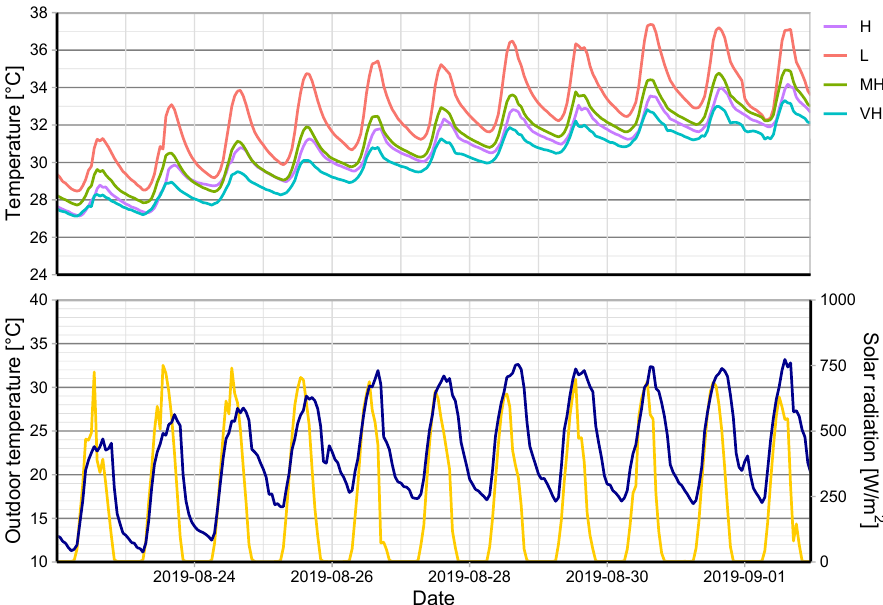
Figure 6. The temperature course in light, medium heavy, heavy and very heavy rooms as a function of outdoor temperature and solar radiation during heat wave 24 August–1 September